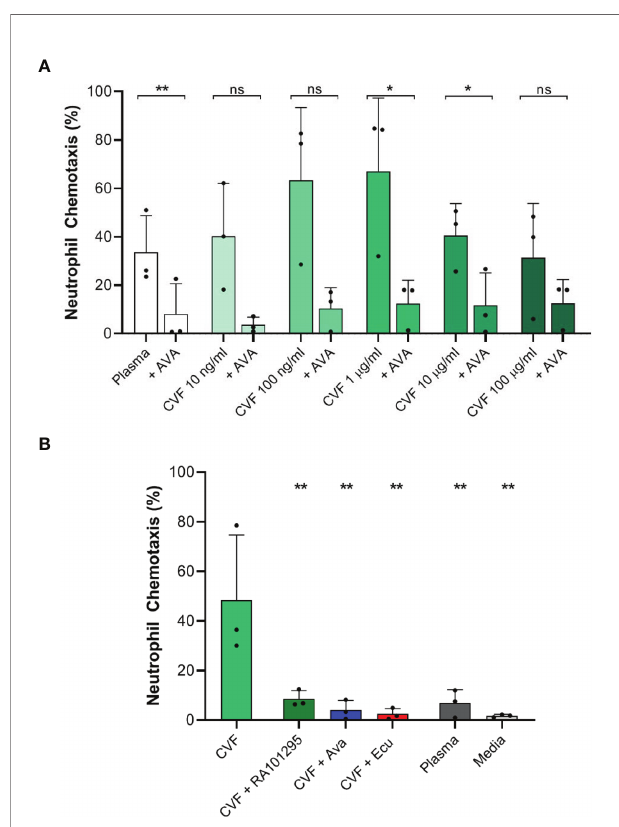
FIGURE 4 | Effect of C5 complement inhibitors on neutrophil chemotaxis towards endogenous complement activation with CVF. (A) Effect of AVA (250 nM) on endogenous complement activation by increasing CVF doses (N=3 donors, *p < 0.05, **p < 0.01; paired two-tailed t -test). (B) Effect of C5 inhibition with ECU (3 µM) and RA101295 (3 µM) on endogenous complement activation by CVF (N=3, **p < 0.01; ns represents not statistical signi fi cant. One-way ANOVA with Dunnett ’ s